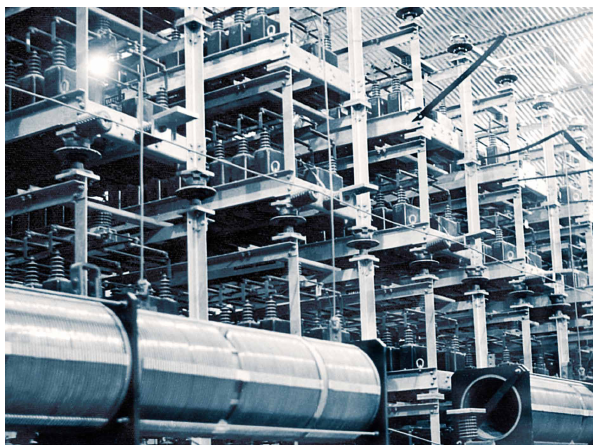
Figure 10. Bank of high-voltage (25kV) capacitors at the Jica- marca Radio Observatory; the bank can store enough energy to per- mit transmitting 5MW pulses up to several milliseconds long, at a rate of roughly 100 pulses per second (picture taken by Ben Bals-